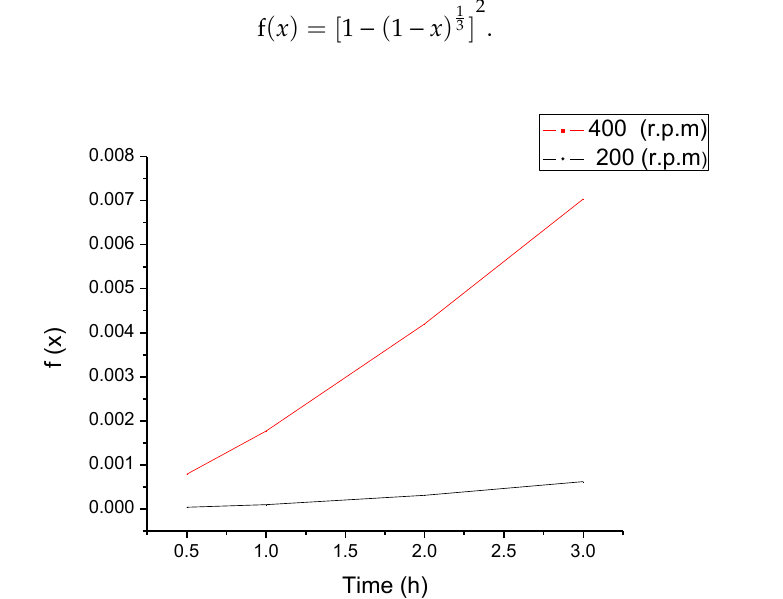
Figure 10. The Jander three-dimensional diffusion model evaluated for fractional mass conversion values ( x ) as a function of time at 20 bar and 32 ◦ C in the ball milling process.